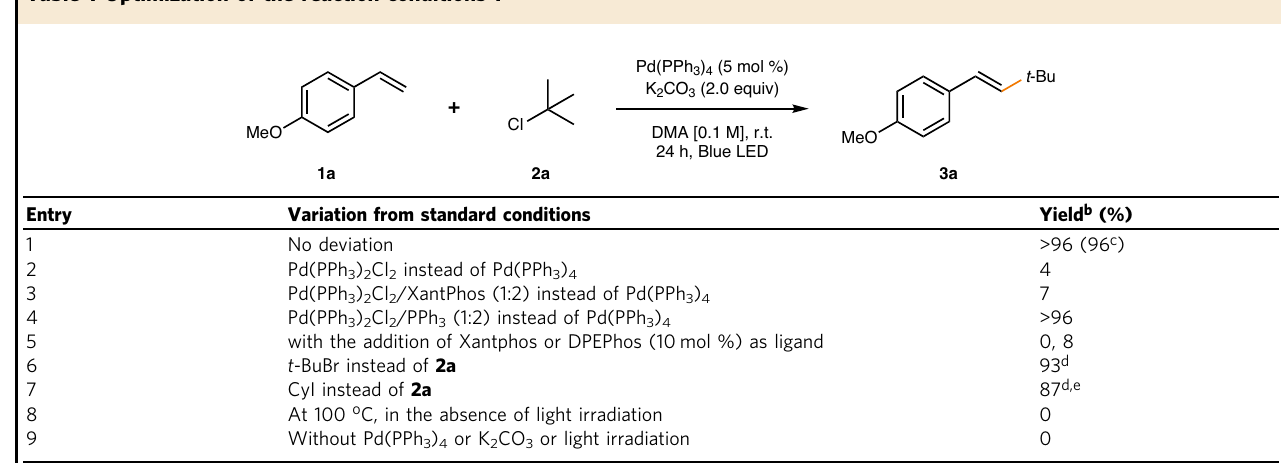
Table 1 Optimization of the reaction conditions a